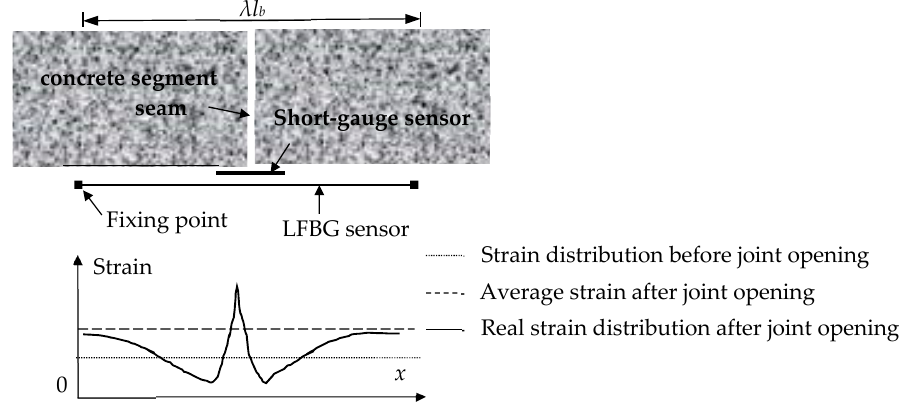
Figure 5. Comparison of strain measurements from the two sensors before and after joint opening.